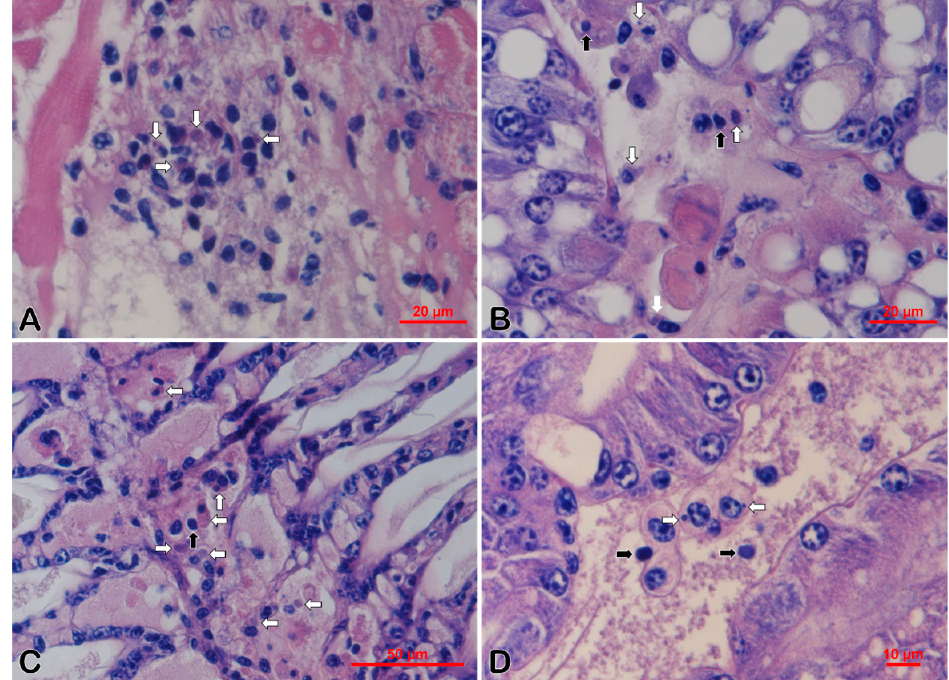
Figure 2. Histopathological features of Davidson’s alcohol-formalin-acetic acid fixative (DAFA) fixed M. rosenbergii ( A – C ) and M. nipponense ( D ) samples 20180620. White arrows show the eosinophilic inclusions and black arrows show the karyopyknotic nuclei. ( A ) Hematoxylin and eosin (H&E) staining of the hematopoietic tissue. ( B , D ) H&E staining of hepatopancreas. ( C ) H&E staining of gills. Bar, 20 µ m ( A , B ), 50 µ m ( C ), and 10 µ m ( D ),